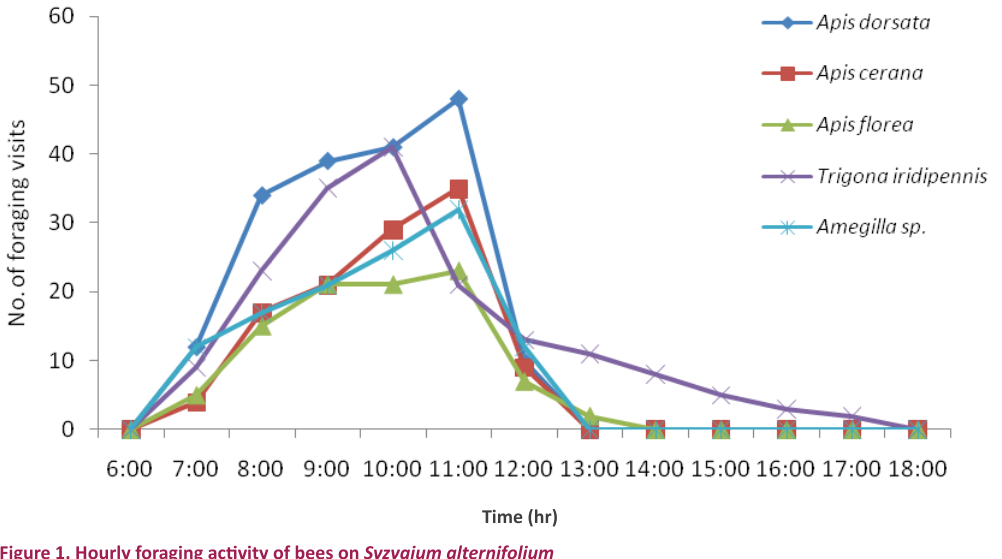
Figure 1. Hourly foraging activity of bees on Syzygium alternifolium